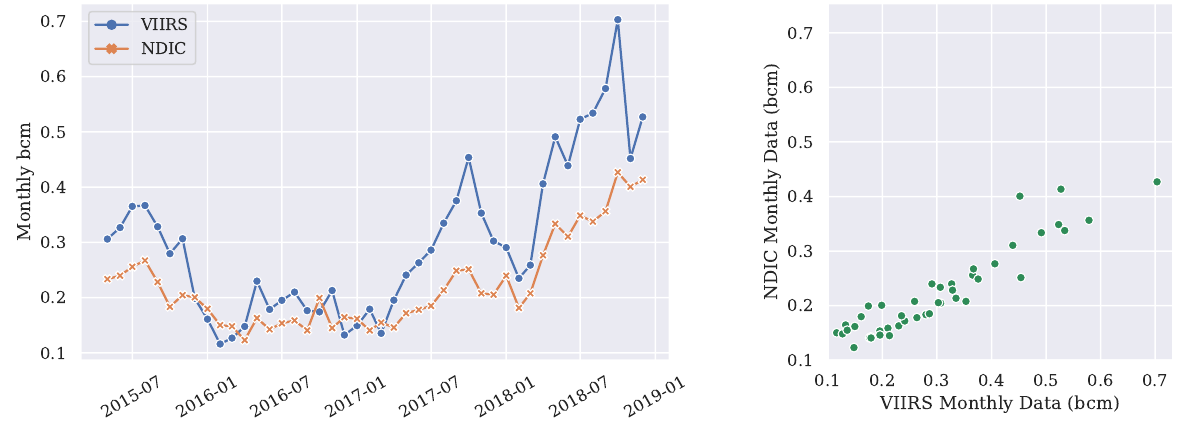
Figure 9. Visualizations of both the NDIC and VIIRS observations at the state level. The left figure presents the time series. The right figure displays the scatterplot using each month’s data points. With the state level reporting, the macroscopic consistency of the NDIC data is exam- ined by using the VIIRS as a benchmark. The posterior distributions and trace plots are displayed in Figure 10. The inferred latent process of the scale factor variations is visualized